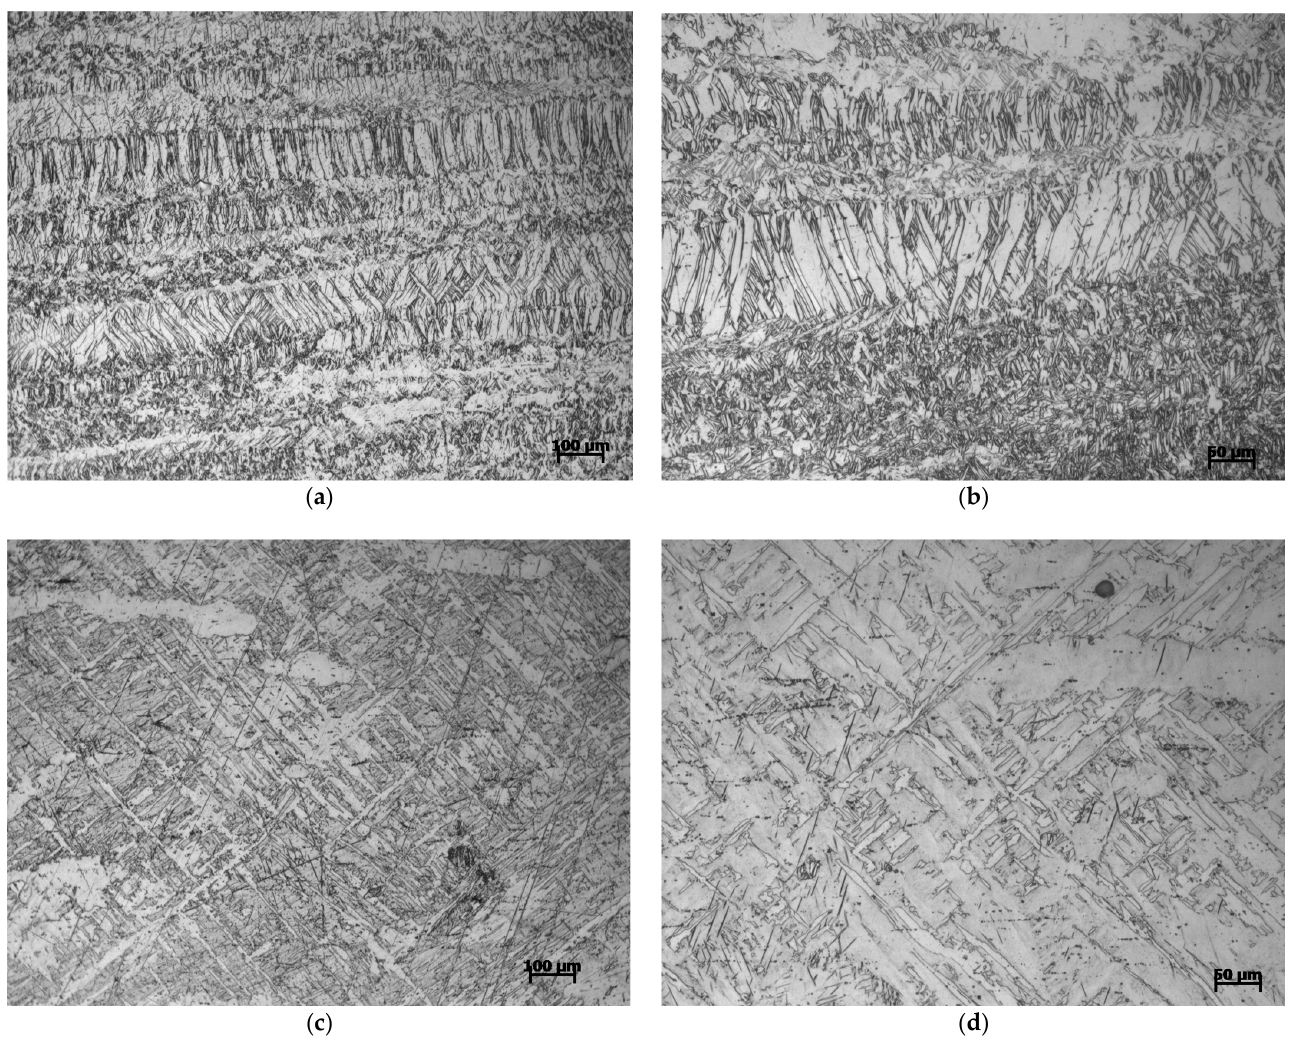
Figure 10. Microstructure of Mg-Al-Ca-Mn alloy compressed in the ED direction under ( a,b ) 700/s strain rate and ( c,d ) 1400/s strain rate.